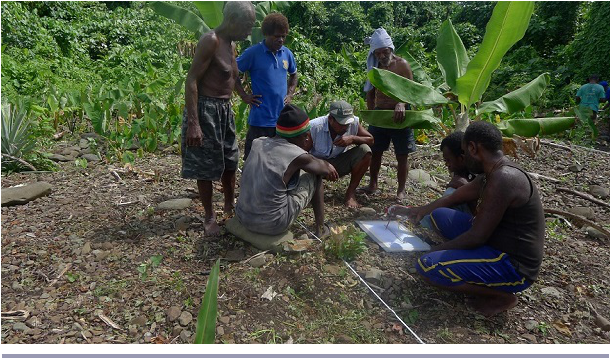
Fig. 4 . Participants in the Sukikki Cultural Heritage